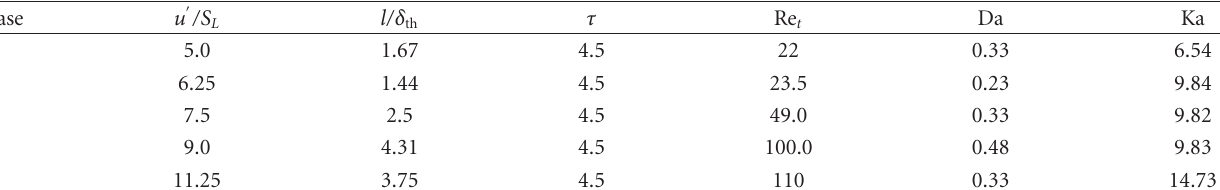
Table 1: List of initial simulation parameters and nondimensional